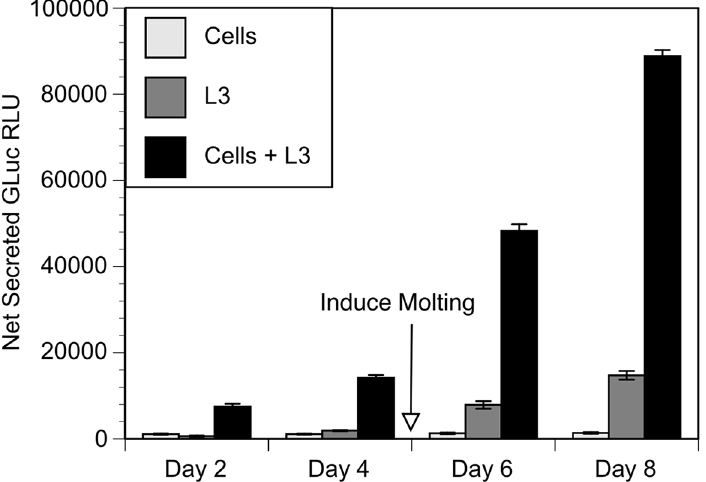
Fig 2. Secreted GLuc activity in cultured transfected L3. L3 = cultured in absence of cells. Cells = BESM cells alone. L3 + cells = L3 cultured and transfected over BESM monolayer. Columns represent mean activity and error bars standard deviation of data obtained from three biological replicates (i.e. independent transfections carried out individual transwells) per treatment. The transfections employing L3 alone and L3 + cells contained approximately 100 larvae per transwell. Values represent net counts calculated by subtracting the relative light units (RLU) seen in media collected from untransfected cells, L3 and cells + L3